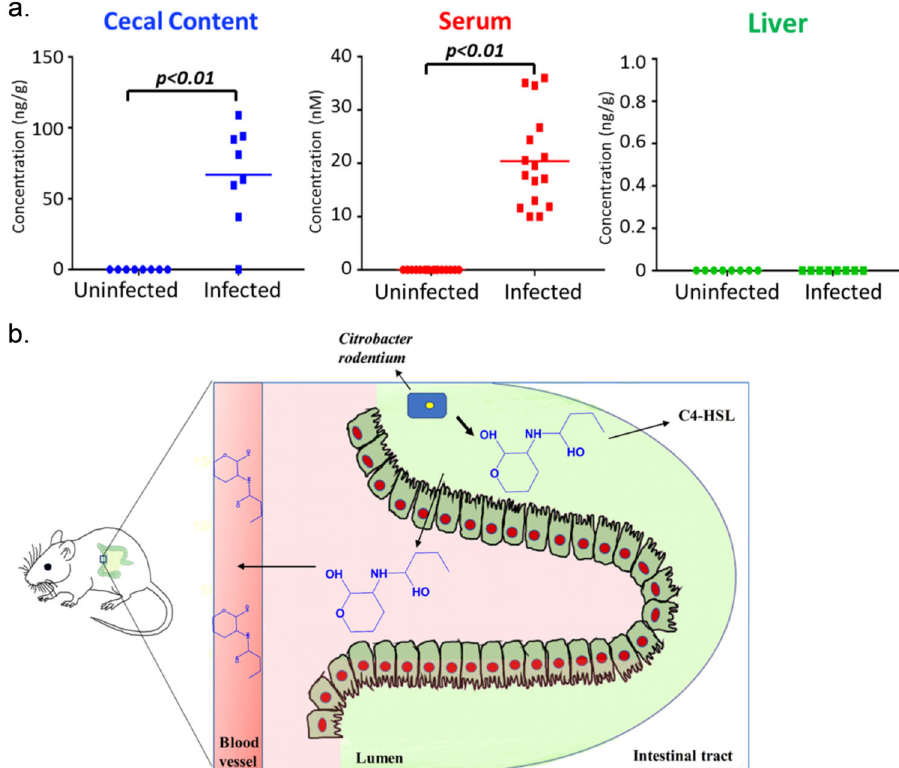
Fig. 4 Distribution of C4-HSL in the infected and uninfected mice. a Differences of C4-HSL level in the cecal content, serum, and liver between uninfected and infected mice. b Schematic representation of in vivo transportation of C4-HSL from Citrobacter rodentium to host